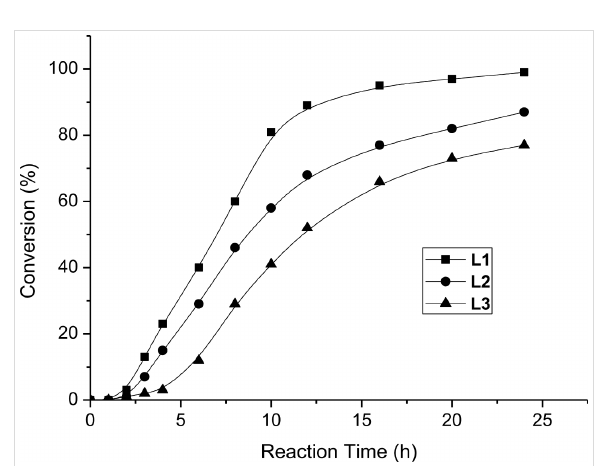
Figure 2: Kinetic profiles of Mizoroki–Heck reactions in water, Na 2 PdCl 4 / L1 (square), L2 (circle), and L3 (triangle). Reaction condi- tions: 4-bromoacetophenone ( 1a , 1.0 mmol), styrene ( 2a , 1.2 mmol), NaOEt (2.0 mmol), 0.01 mol % Na 2 PdCl 4 , Pd/ L = 1:1 (molar ratio), 1.5 mL H 2 O, 100